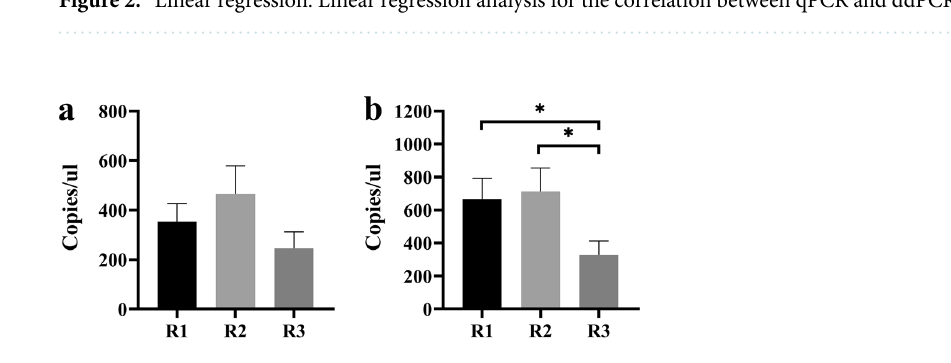
Figure 3. Correlation between miR-197-3p and cumulative asbestos exposure. Correlation between miR- 197-3p sera expression and cumulative asbestos exposure in WEA cohort highlighted by RT-qPCR ( a ) and by dd-PCR ( b